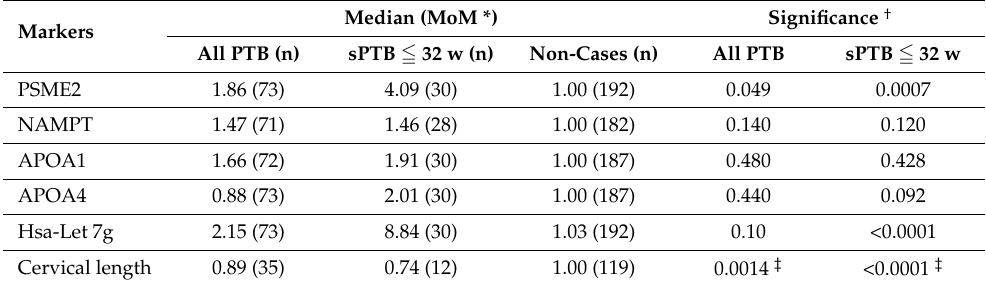
Table 4. Preterm birth and MoMs of RNA markers, cervical length (CL). Markers